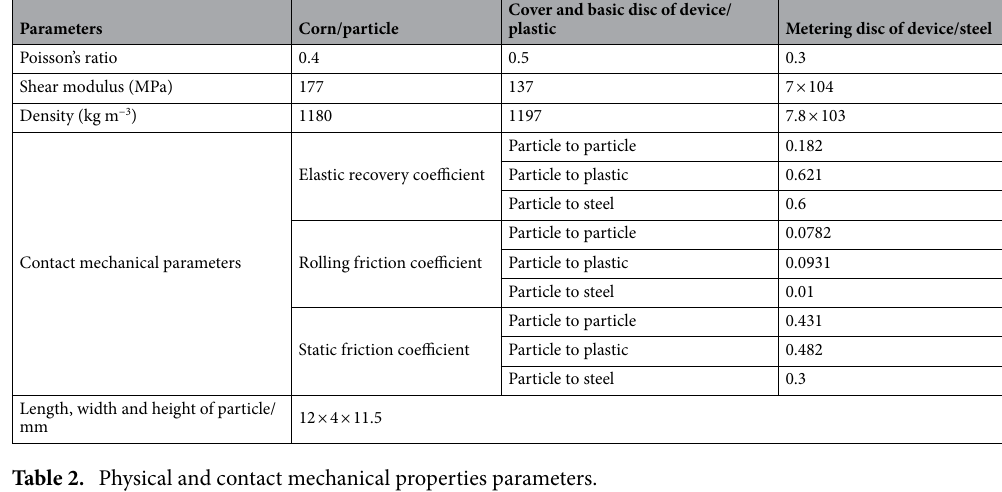
Table 2. Physical and contact mechanical properties parameters.